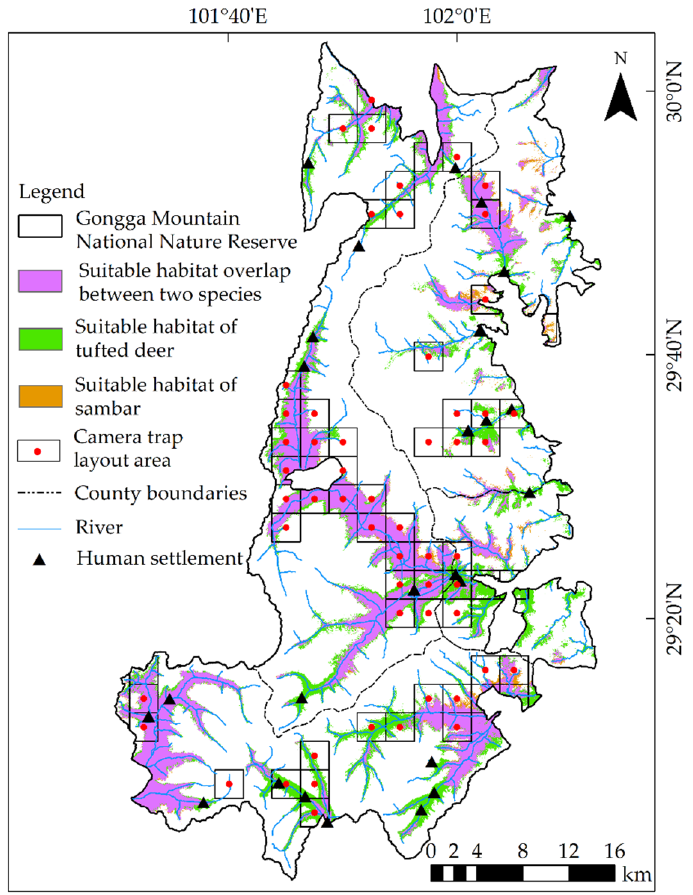
Figure 3. Distribution of tufted deer and sambar habitats in the Gongga Mountain National Nature Reserve, China.